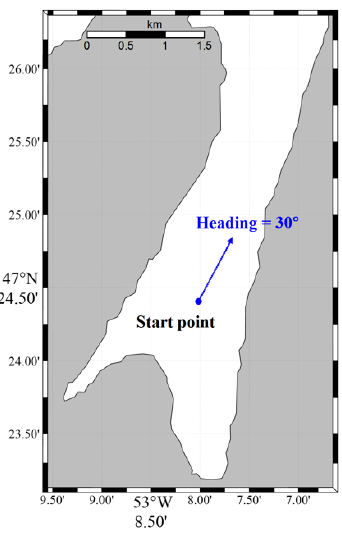
Figure 15. Trajectory of the glider during a mission when following a constant heading of 30 ◦ .